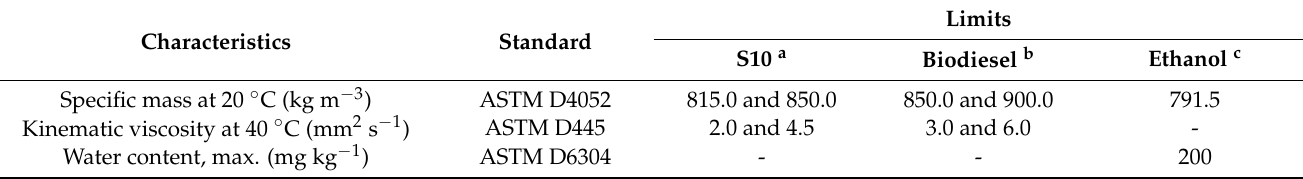
Table 1. Specifications of the fuels used in the preparation of the mixtures.